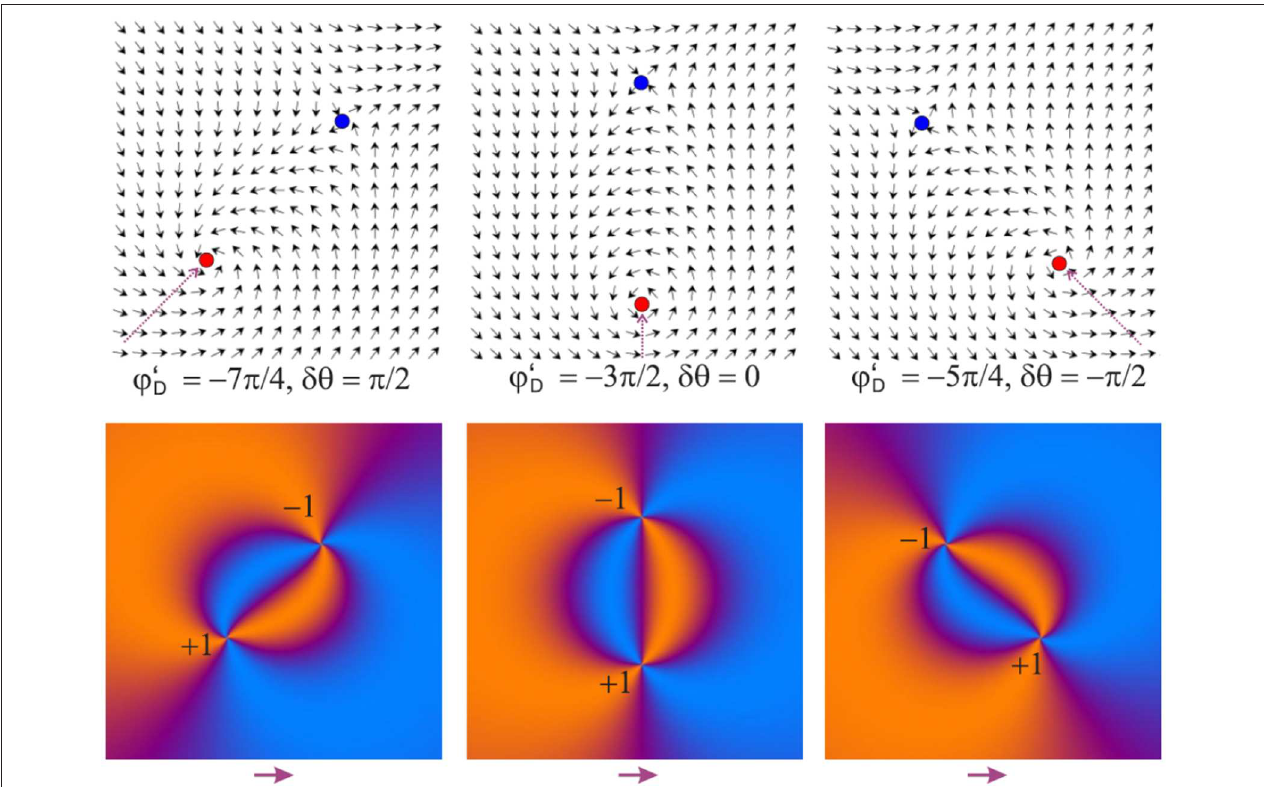
π/ 2) from left to right in a ( π/ 2,0, = − 1 defect and the blue dot the 1 defect. The bottom row + −